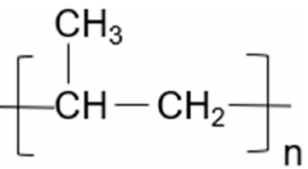
Figure 3. Chemical compound of polypropylene (plastic